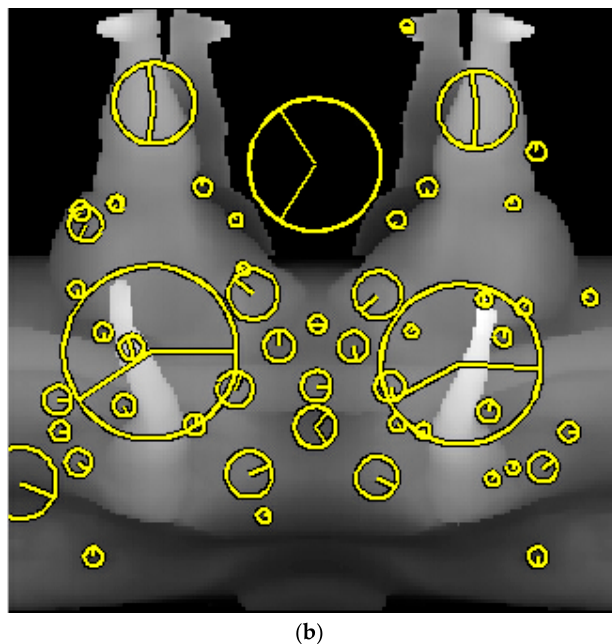
Figure 2. The cylinder around a model and its panoramic view-based range image; ( a ) Cylinder; ( b ) Panoramic view-based range image.